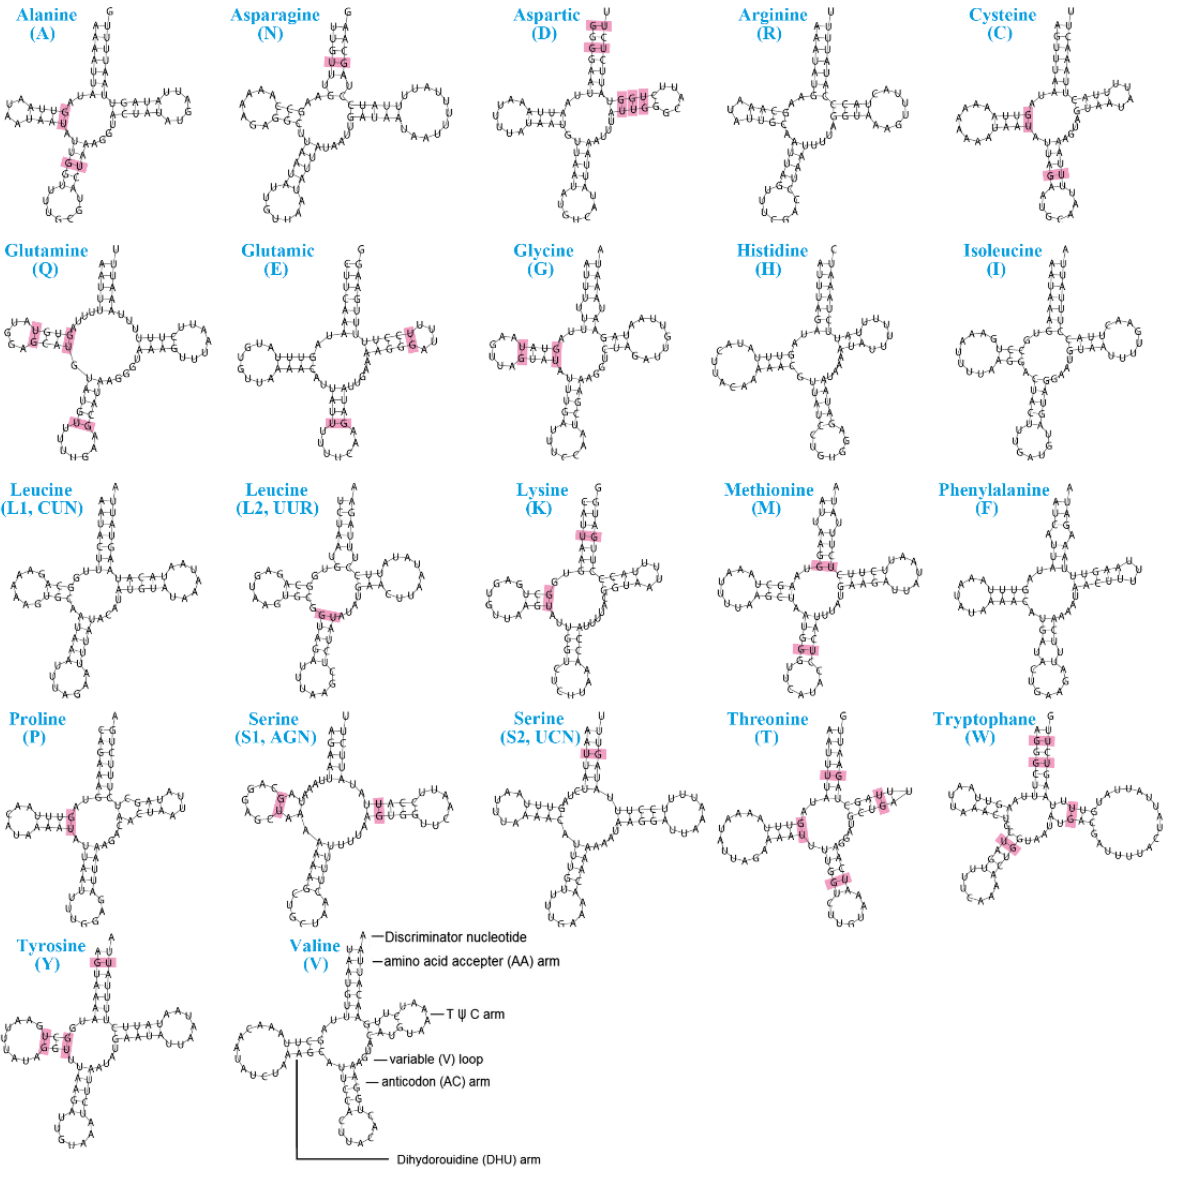
Figure 4. Secondary structures of tRNA genes in the mitogenome of Haplodiplatys aotouensis . Mis- matched base pairs are indicated by red boxes.